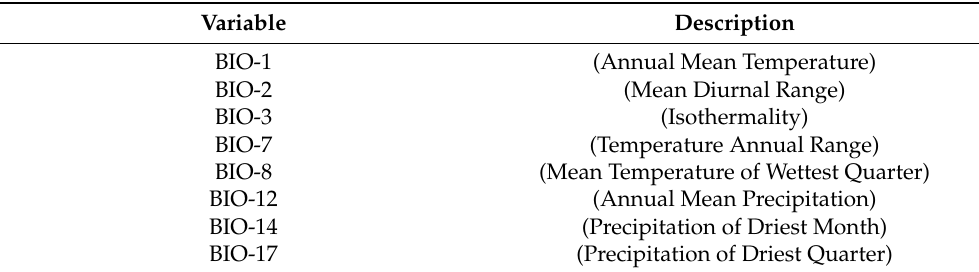
Table 3. Bioclimatic variables selected for modeling the distribution of Valeriana wallichii in the present